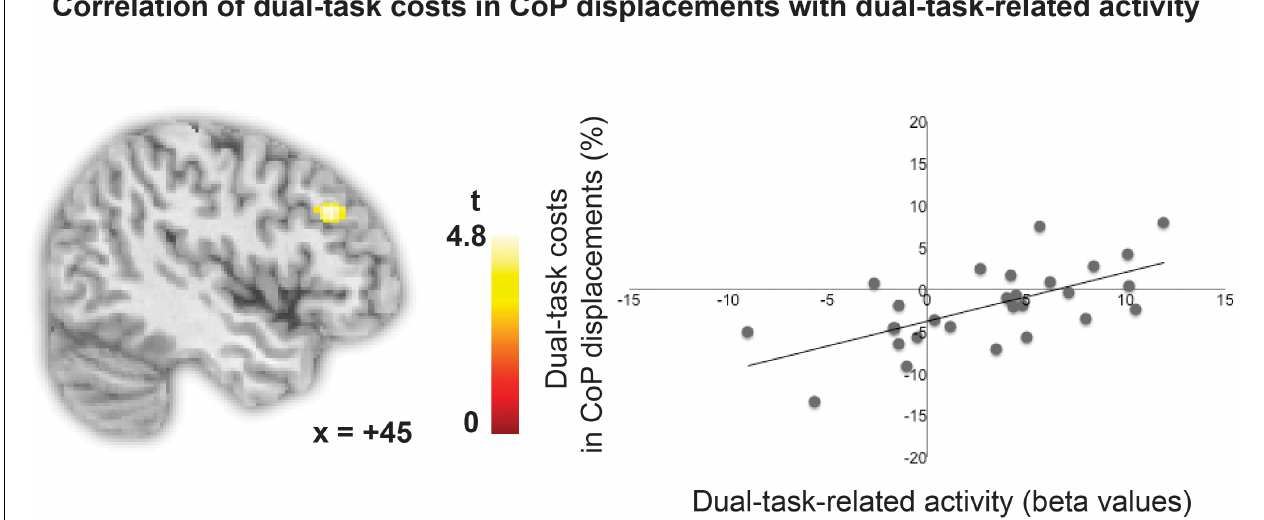
FIGURE 4 | Correlation of relative costs in CoP displacements with dual-task-specific brain